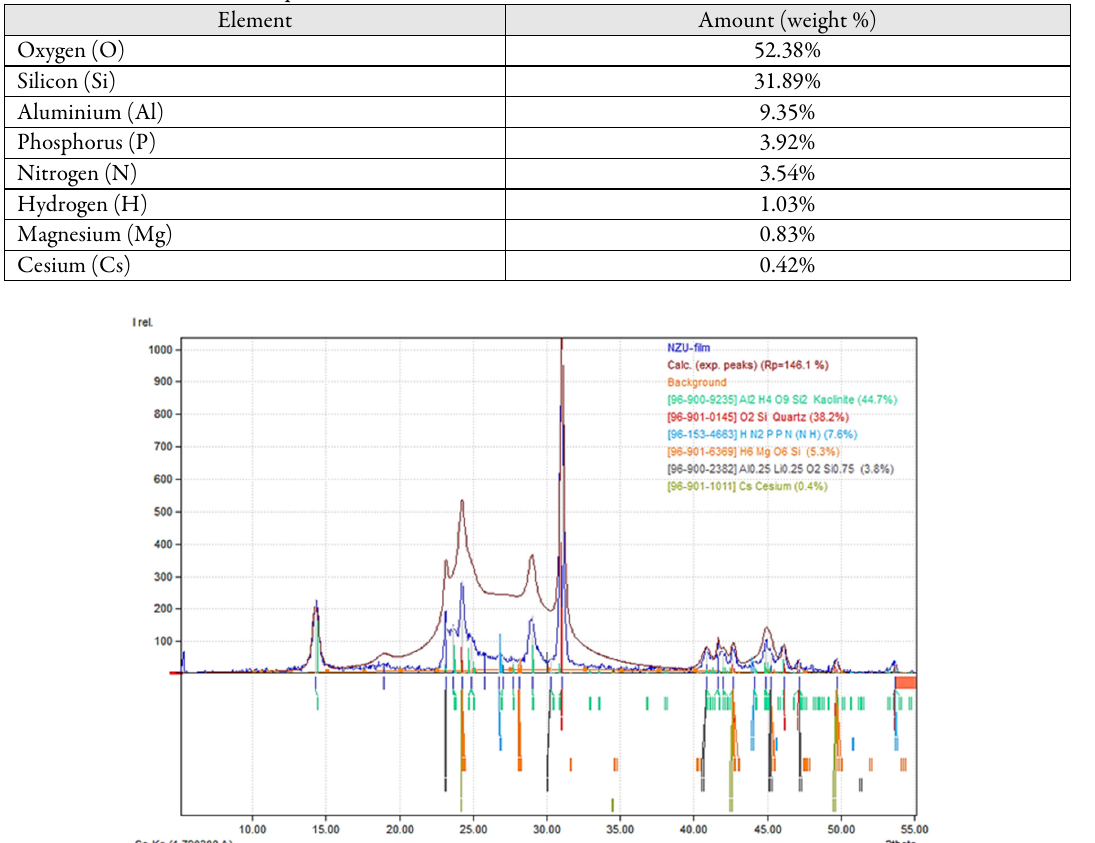
Figure 1. Diffraction pattern of the chemical components of calabash